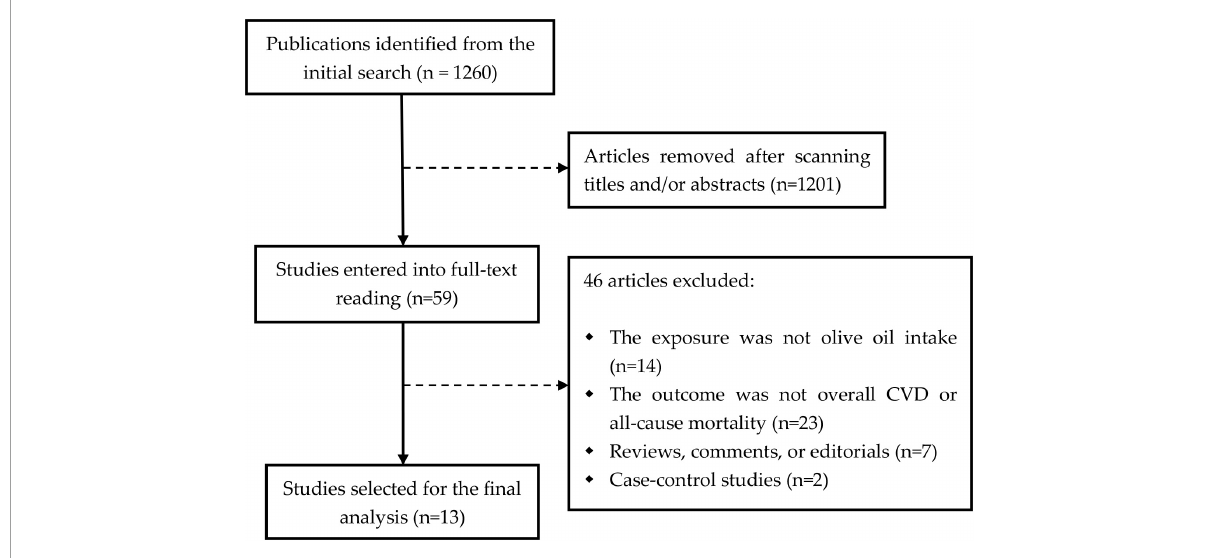
FIGURE1 The flowchart of study searching process. CVD, cardiovascular